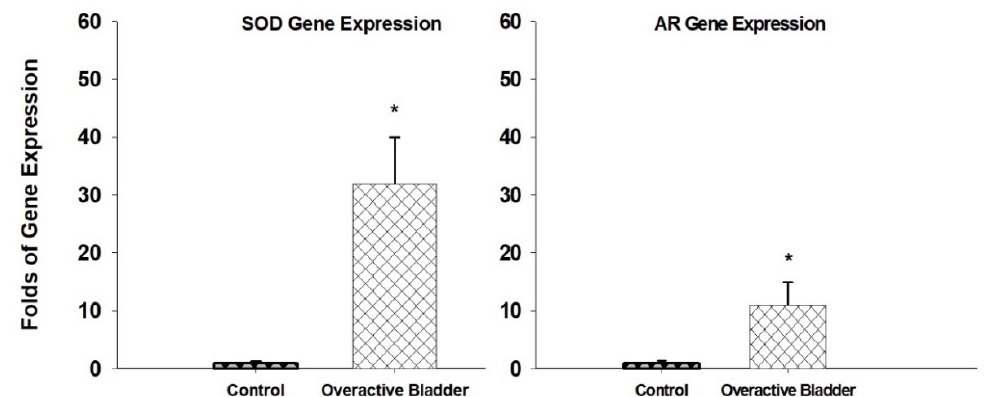
Figure 2. SOD and AR gene expressions are significantly upregulated in the ischemic overactive bladder tissues in comparison with controls. * Indicates significant differences versus control. This figure is taken from our previous publication [40].